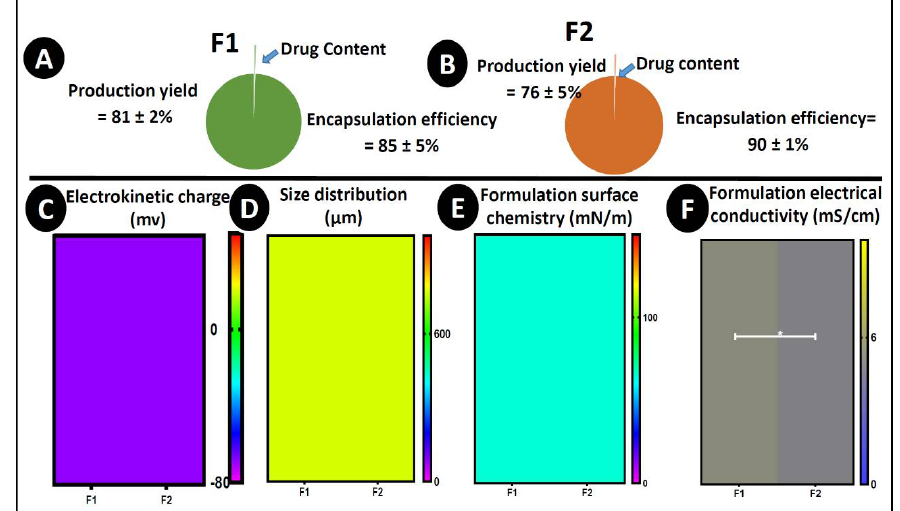
Figure 2. Drug content, production yield, and encapsulation efficiency ( A , B ), ( C ) electrokinetic charge, ( D ) size analysis, ( E ) surface tension and ( F ) conductivity. N = 3, mean ± SEM. F1: PB–LVSA microcapsules and F2: PB–ULCA–LVSA microcapsules. PB—probucol; LVSA—low-viscosity sodium alginate; ULCA — unconjugated lithocholic acid. * p < 0.01.